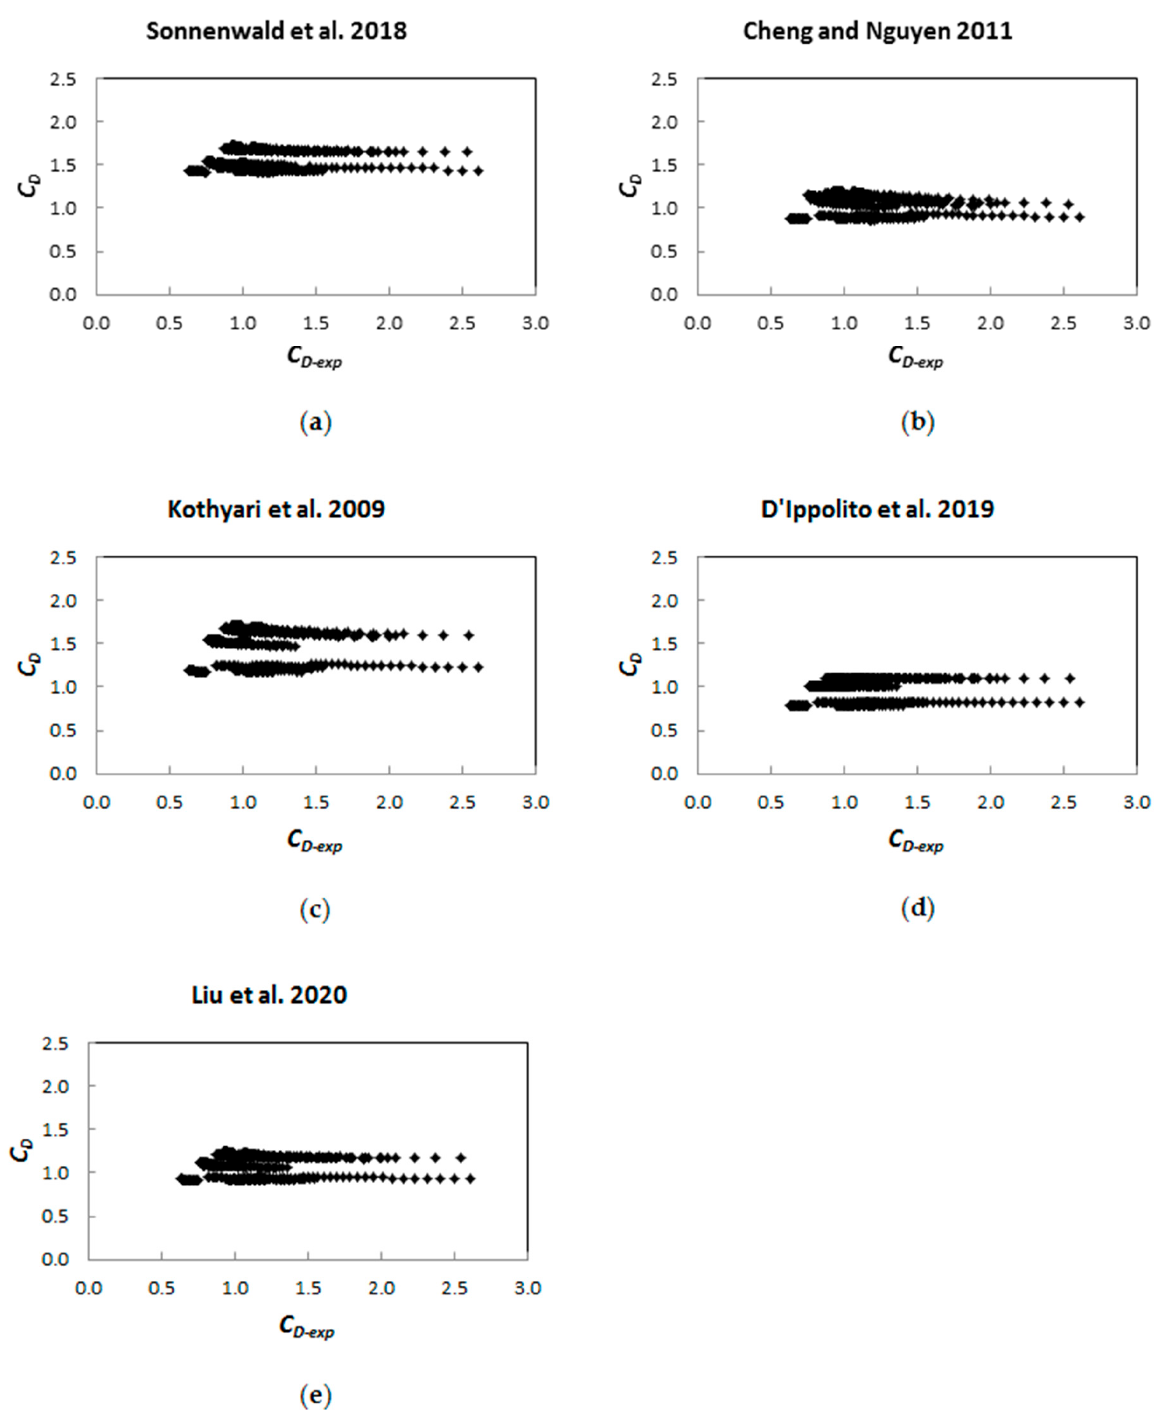
Figure 3. Comparison between the calculated and observed C D values using different predictors. ( a ) Sonnenwald et al. [54], Equation (3); ( b ) Cheng and Nguyen [61], Equation (14); ( c ) Kothyari et al. [11], Equation (15); ( d ) D’Ippolito et al. [63], Equation (16); ( e ) Liu et al. [57], Equation (18).